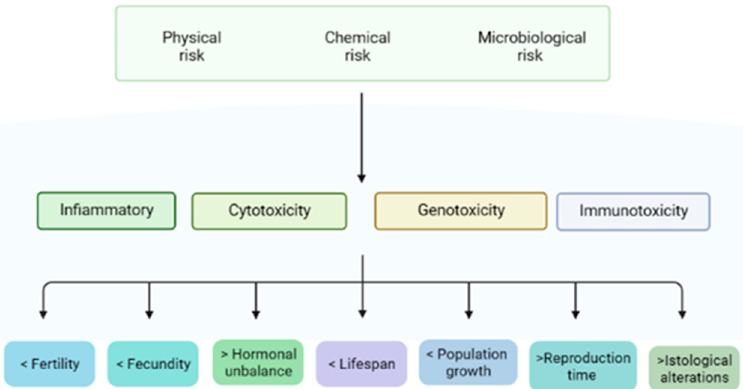
Figure 2. Risks, effects and consequences of MPs/NPs on Figure 2. Risks, e ff ects and consequences of MPs/NPs on reproduction.